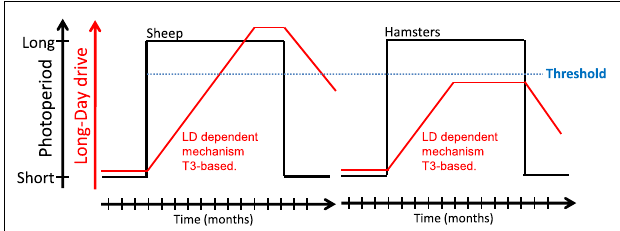
FIGURE 4 |A model for long-day refractoriness [adapted from Figure 2 in Ref. (152)] . In sheep (left panel) and hamsters (right panel), exposure to long days (black line) leads to the development of a mechanism of unknown nature, most likelyT3-dependent (red line). In sheep, the long-day drive eventually exceeds a “threshold” (blue dotted line); the animal then becomes refractory to long days and spontaneously reverts to an SP phenotype. In hamsters, the long-day drive never exceeds the threshold and the animal displays the LP phenotype indefinitely; exposure to SP is mandatory to get the SP physiological